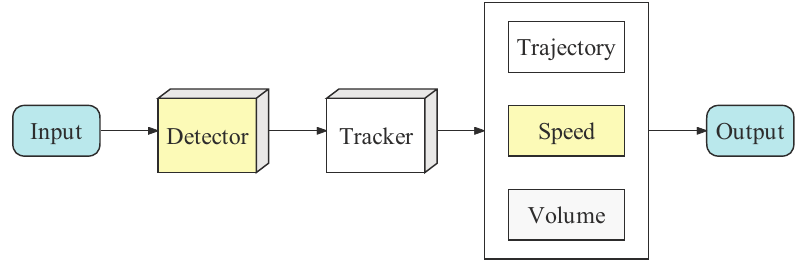
Figure 1. The detection-based vehicle tracking model.